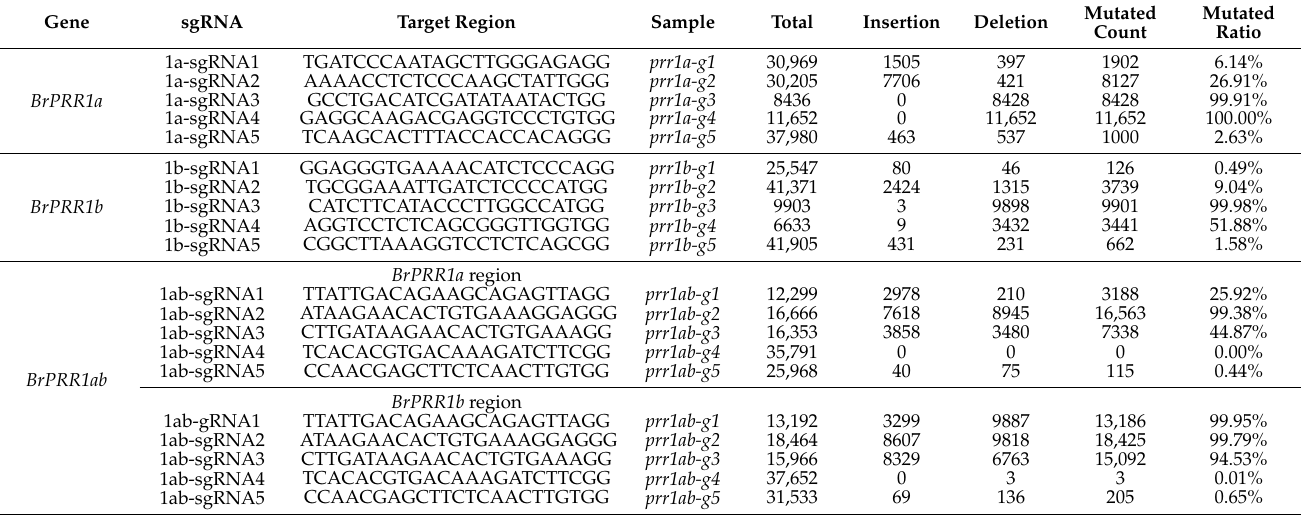
Table 2. The indel frequencies of each target region in T 0 mutants of Chinese cabbage by NGS-based targeted deep sequencing.